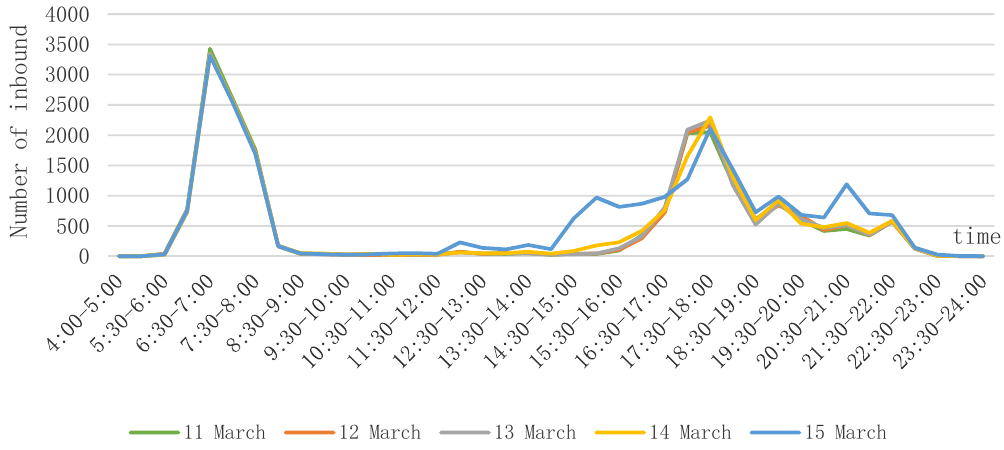
Figure 4. Distribution of departure time of school commuting.